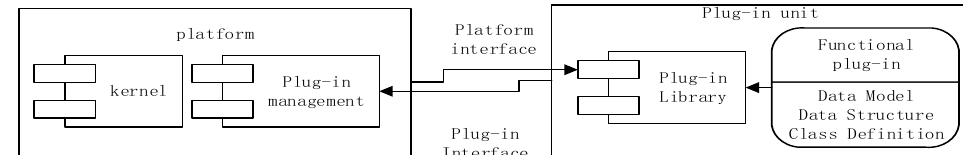
Figure 5. Platform and plug-in development mode.